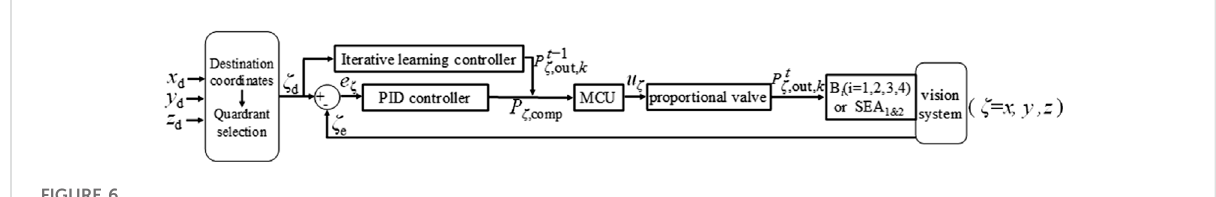
FIGURE 6 Closed-loop control system based on PID+iterative learning